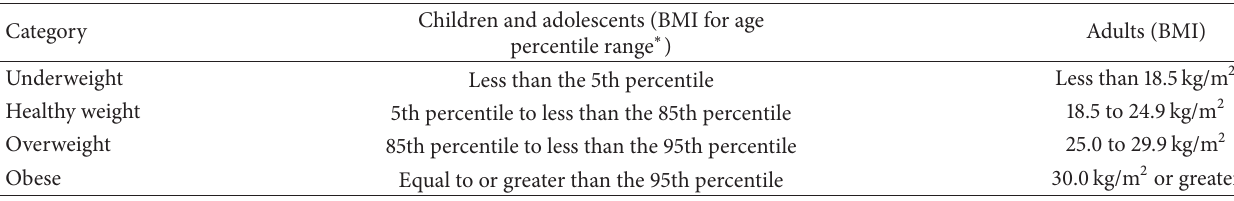
Table 5: Overweight and obese children and adolescents